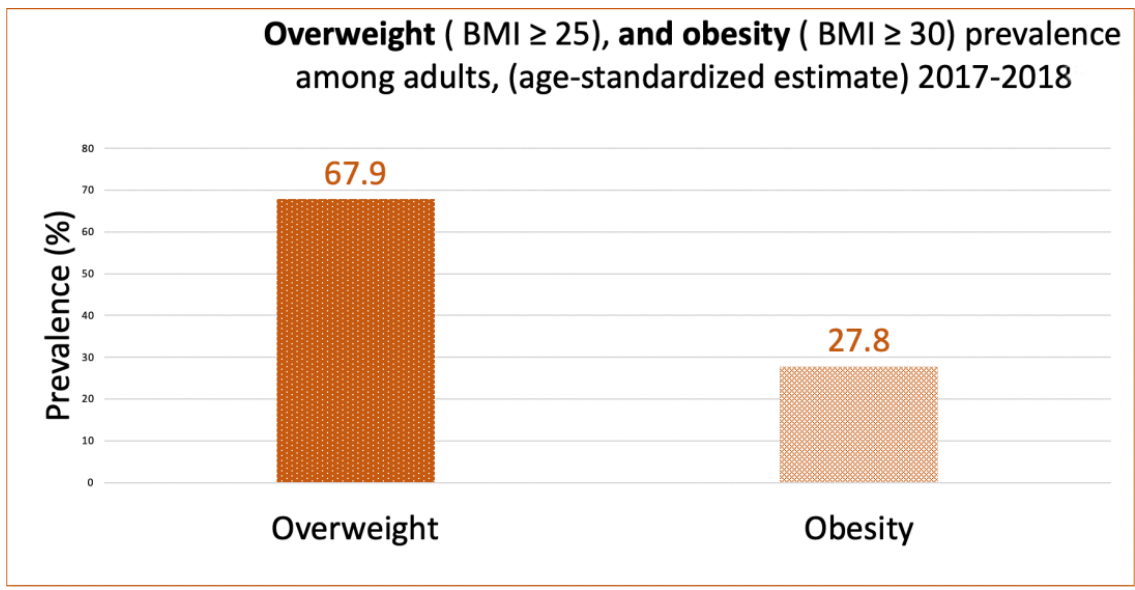
Figure 7. The prevalence of overweight and obesity (age-standardized estimate), 2017 – 2018 (the UAE). Source: https://www.mohap.gov.ae/Files/MOH_OpenData/1556/UAE_NHS_2018.pdf (ac- cesséd on 5 December 2022) [82].